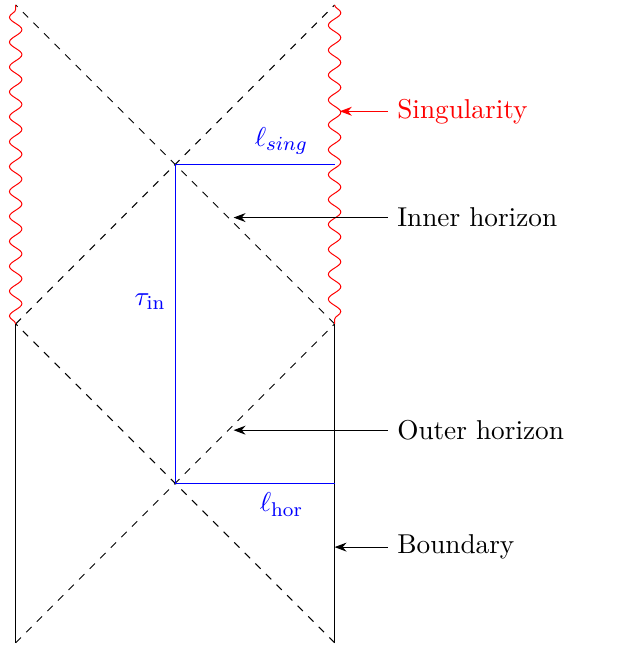
Figure 2 . The three lengths τ in , ‘ hor , ‘ sing shown on the Penrose diagram of the charged black hole in